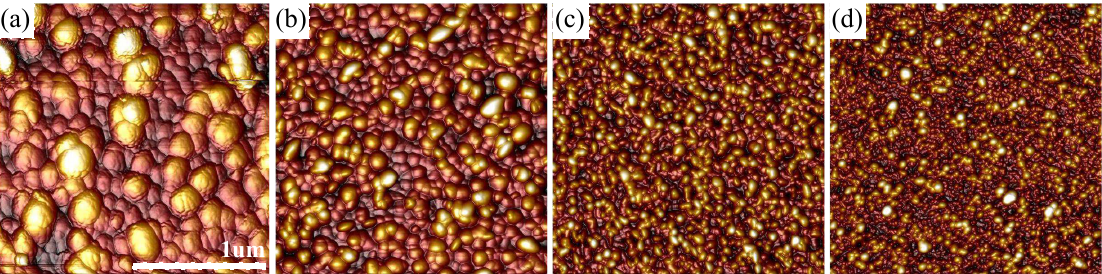
Figure 1. Atomic Force Microscope (AFM) images (2 µ m × 2 µ m) of Ti layer surfaces for: ( a ) Ti(1470), ( b ) Ti(743), ( c ) Ti(363), and ( d ) Ti(93)